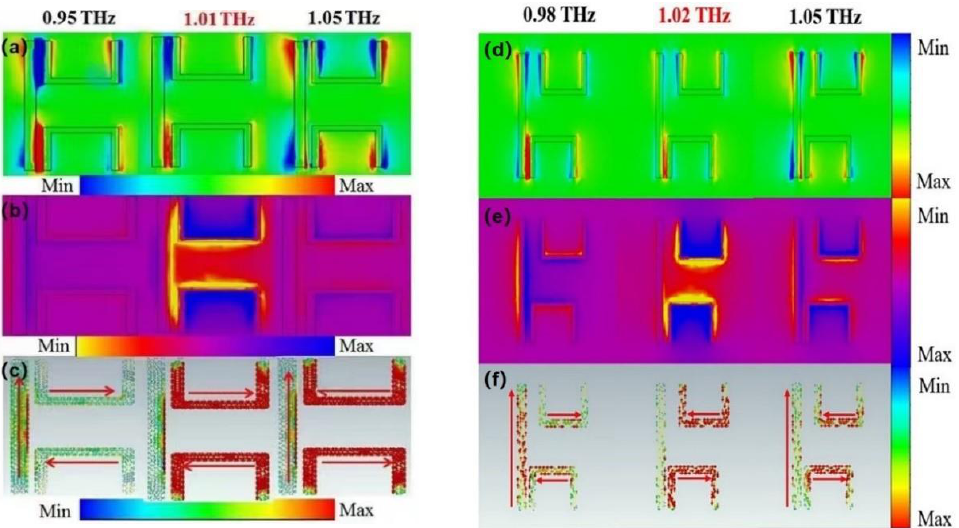
Figure 3. The distribution of electromagnetic field and surface current corresponding to three different characteristic frequencies. ( a , b ) The electromagnetic field distribution at frequencies of 0.95 THz, 1.01 THz, 1.05 THz, and the coupling between the bright and dark mode at troughs of 0.95 THz and 1.05 THz are very weak; ( c ) The surface current distribution of symmetrical structure at different frequencies (the red arrow indicates the current direction), the current directions at the low-frequency trough are opposite, while at high-frequency trough are in the same direction; ( d – f ) The electromagnetic field distribution of asymmetric structure at three characteristic frequencies.